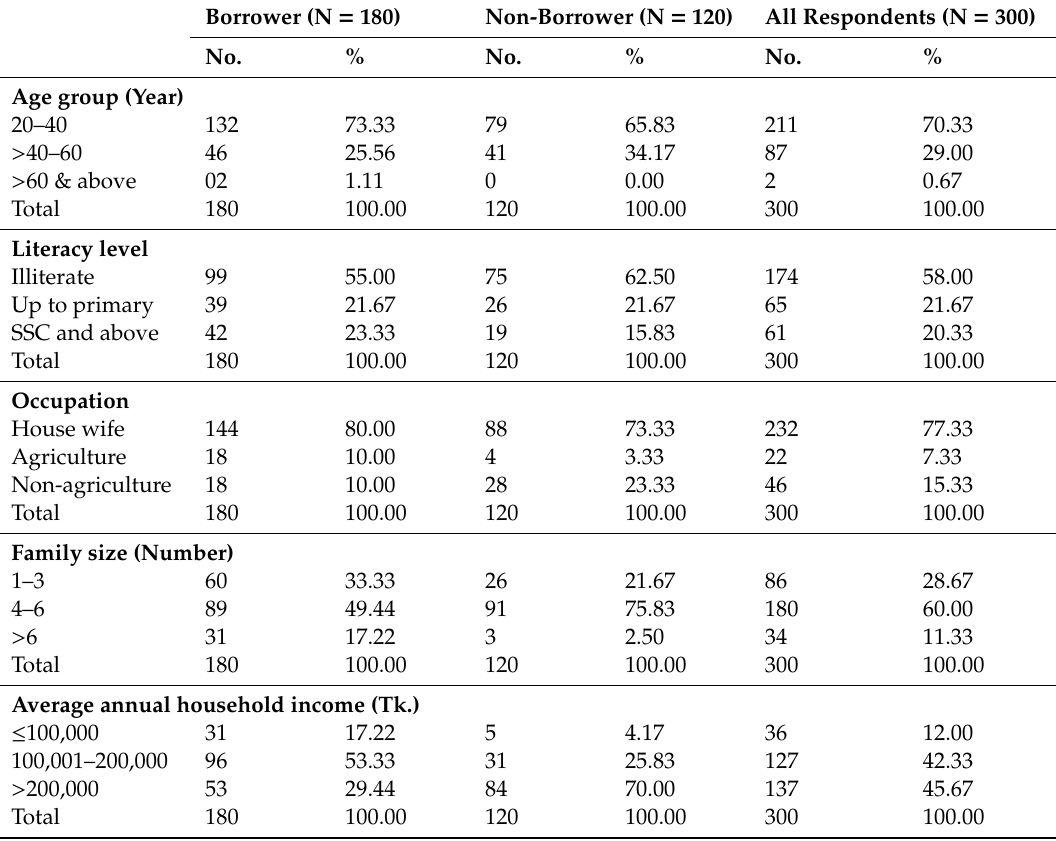
Table 3. Socio-economic characteristics of the